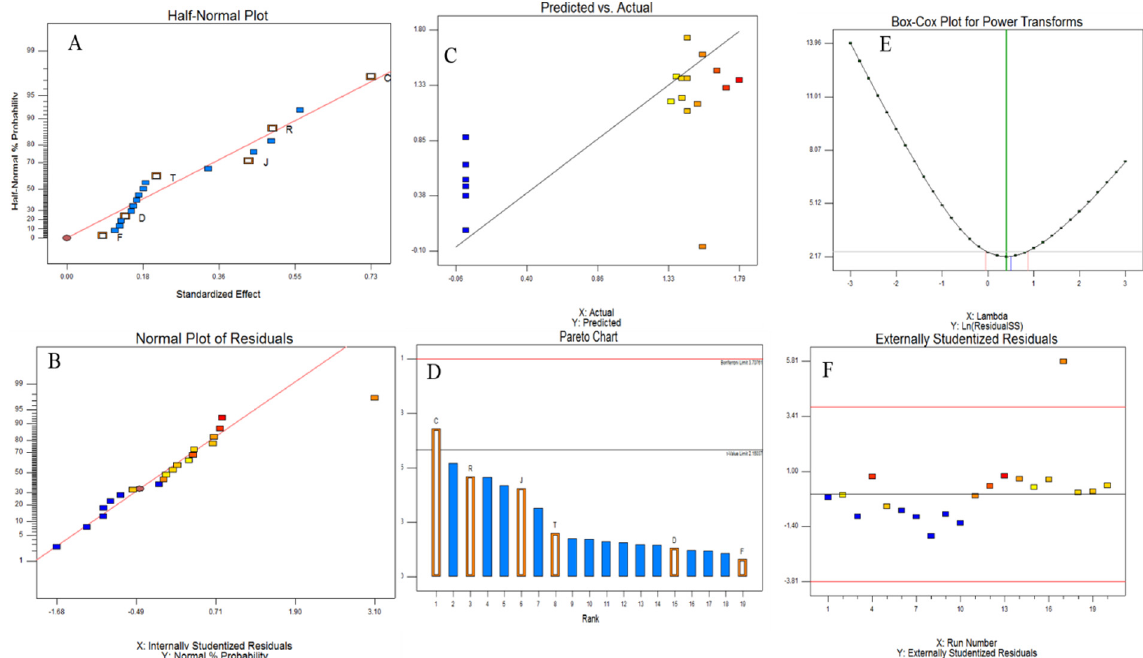
Figure 2. Effects of the different variables on tyrosinase production by A. terreus using Plackett–Burman experimental design. The normal probability plots of the variables for tyrosinase production were determined by the first-order polynomial equation ( A , B ). Plot of correlation between predicted and actual tyrosinase activity of A. fumigatus ( C , D ), Pareto chart illustrates the order of significance of each variable. ( E ) Box-Cox power transform. ( F ) Plot of standardized effect with the normal probability. The symbols C refers to the response ammonium nitrate, R refers to glucose, J refers to asparagine, T refers to incubation time, D refers to beef extract, F refers to yeast extract.